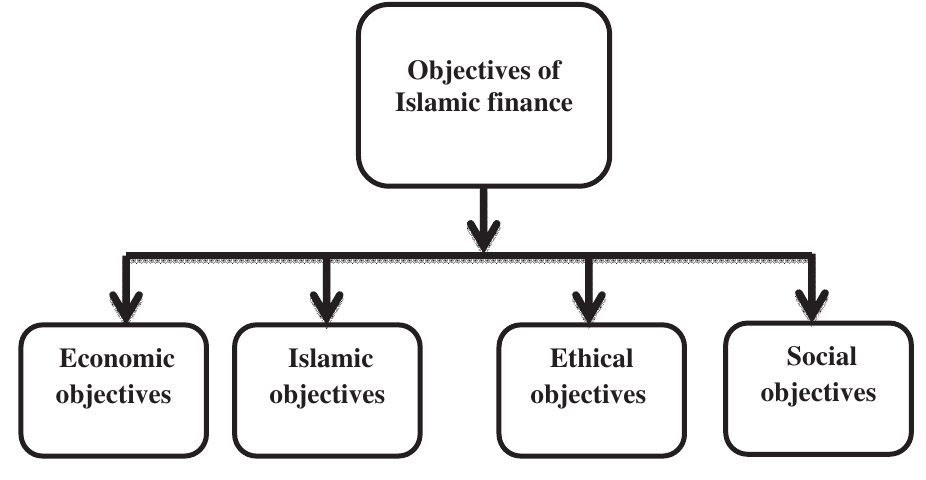
Fig. 3. Objectives of Islamic finance